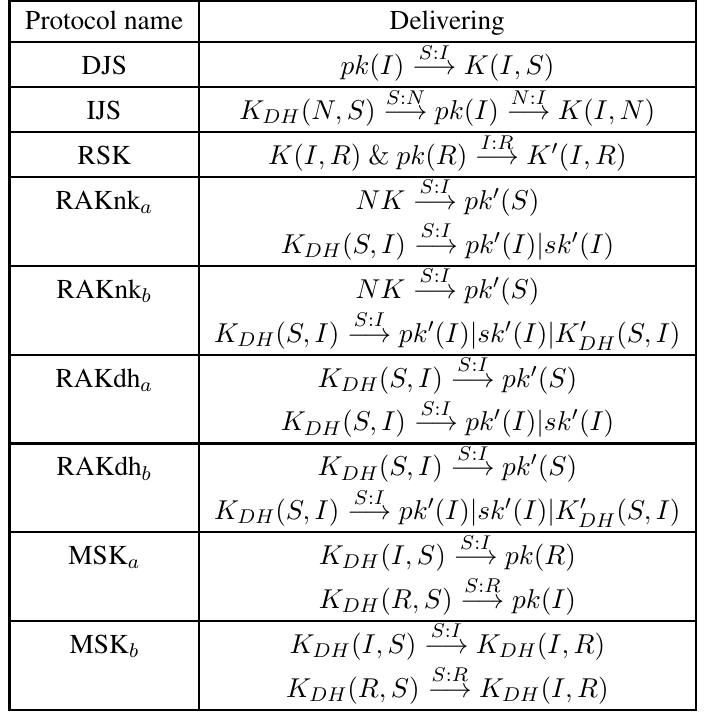
A : B denotes that K −→ K | K & K 1 2 3 4 and K 1 2